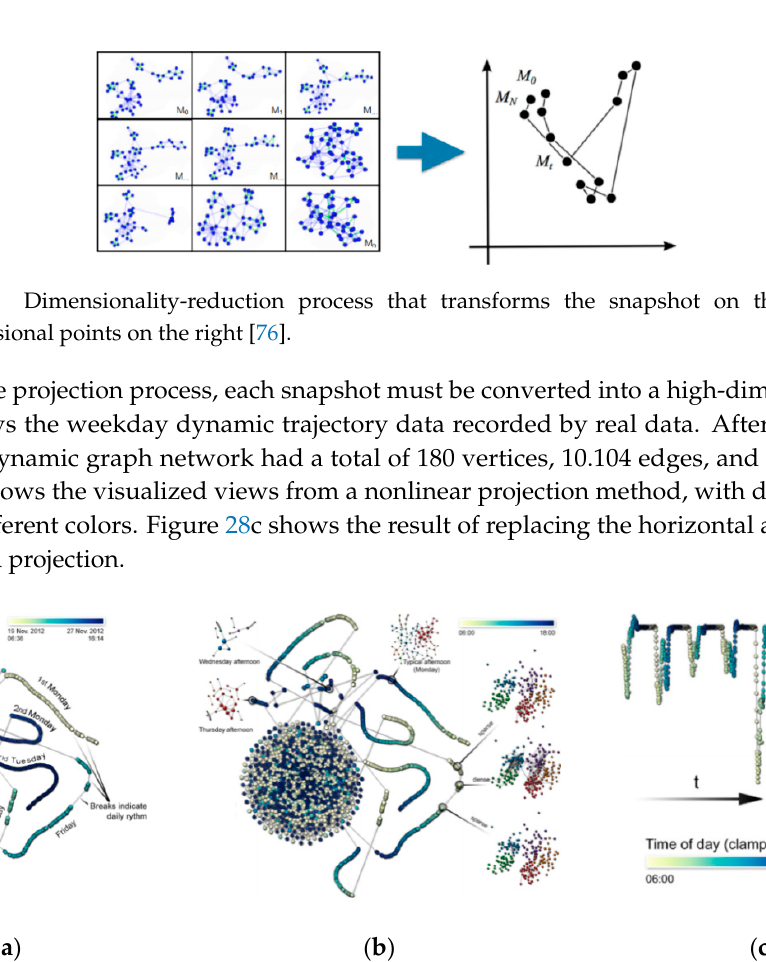
high-school contact patterns [76]: ( a , b ) temporal-information maps in different periods; and ( c )